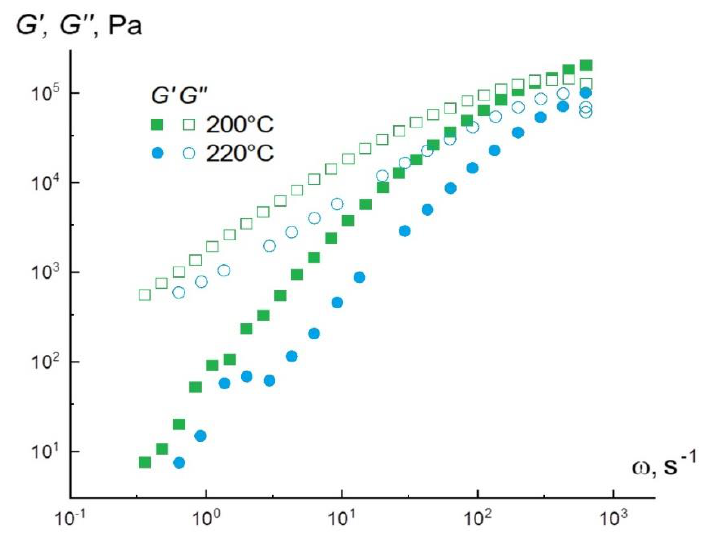
Figure 5. Frequency dependences of elastic and loss moduli for polylactide at different tempera- tures.